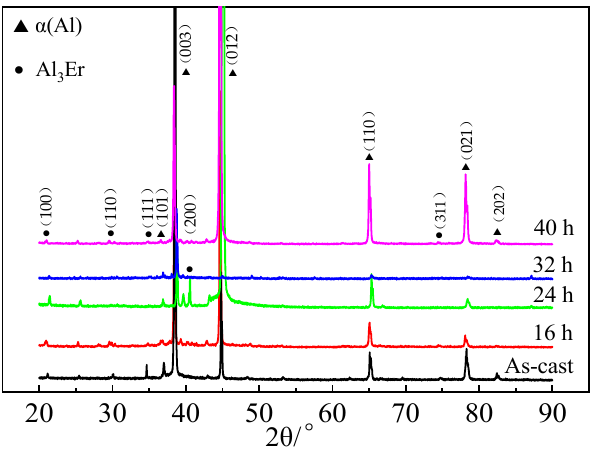
Figure 9. XRD patterns of Al-5Zn-0.03In-1Er alloy by treatment at 615 °C for different times.